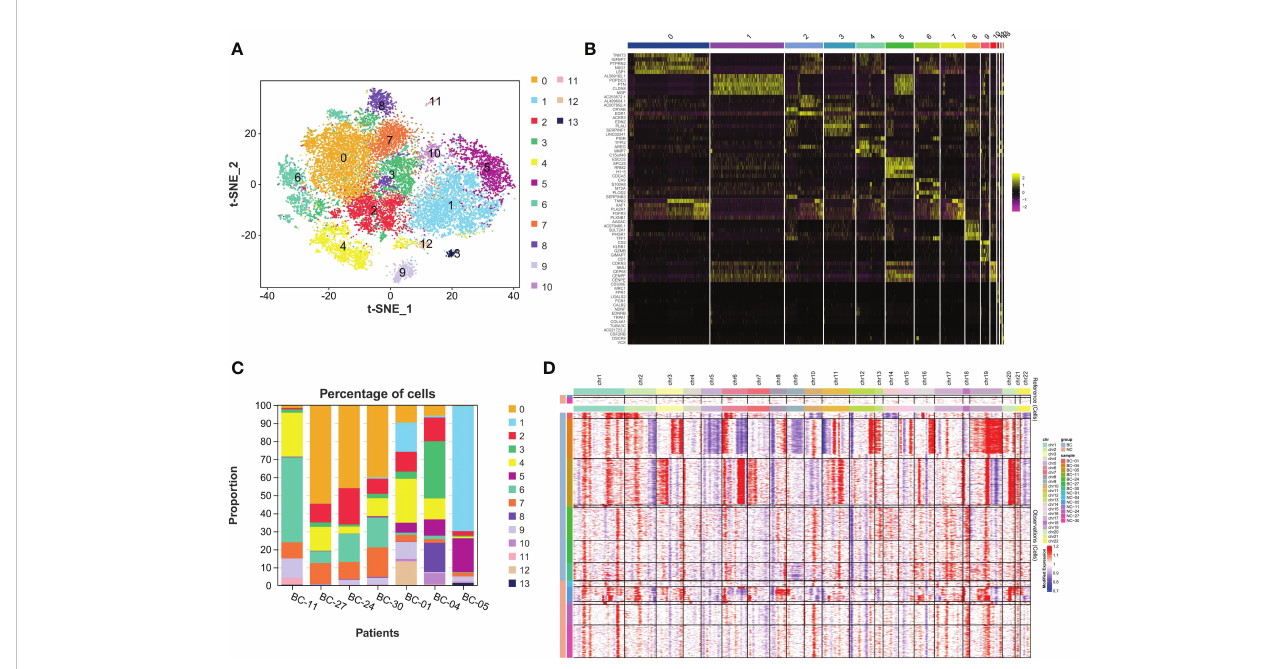
FIGURE 2 The intra-tumor and inter-tumor heterogeneity of BC. (A) The malignant epithelial cells were extracted and re-clustered into 14 clusters. (B) Top 5 marker genes of 14 malignant cell clusters are displayed in the form of heatmaps. (C) Varying proportions of 14 cell types between BC groups. (D) The CNV distribution heatmap in bladder cancer and corresponding normal tissues. BC, bladder cancer; CNV, copy number